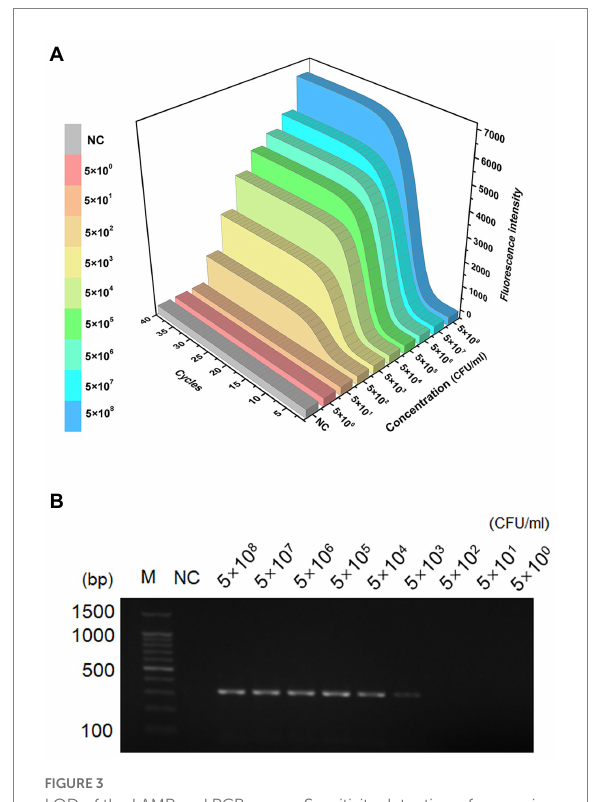
FIGURE 3 LOD of the LAMP and PCR assays. Sensitivity detection of genomic DNA of S. aureus by MIRA assay (A) and PCR (B) , The template levels from 5.0 × 10 8 to 5.0 × 10 0 CFU/ml. NC, negative control; M, maker.